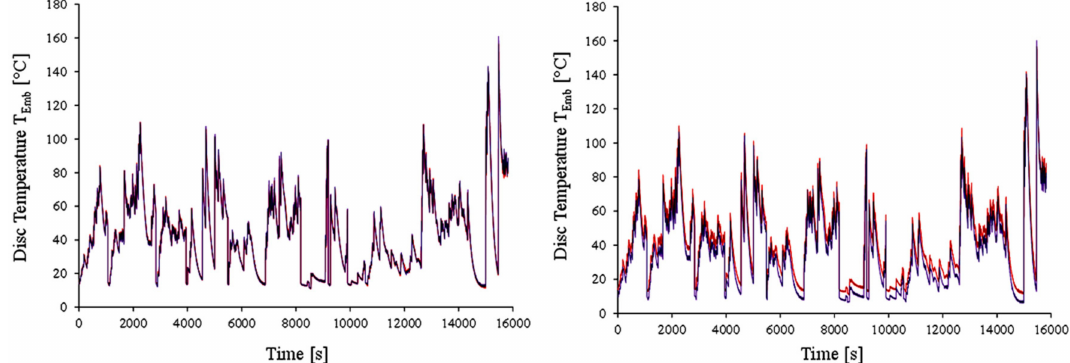
Figure 7. Disc temperature profile measured by TC Emb for Lab 4 during T1. Left-hand side depicts R2 (red line) vs R3 (purple line). Right-hand side depicts R2 (red line) vs R5 (purple